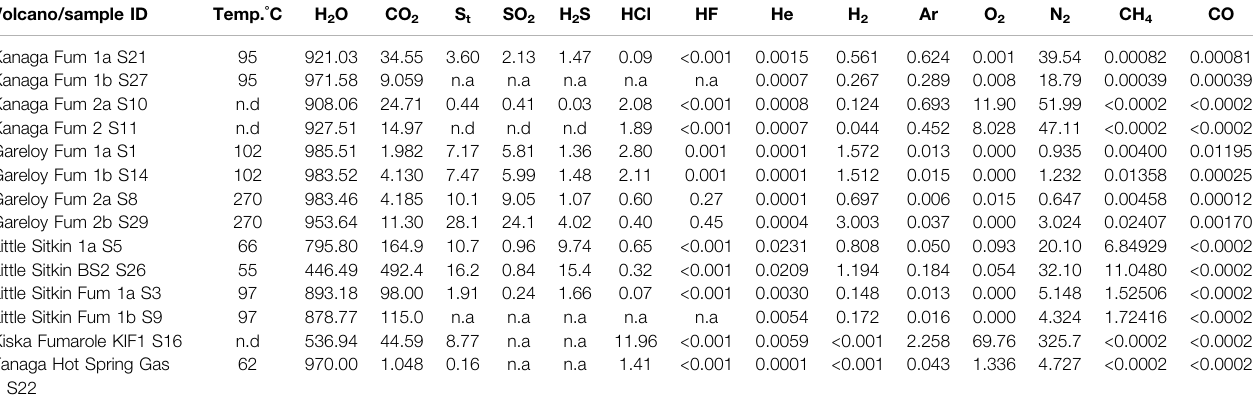
TABLE 1 | Gas chemical composition in mmol/mol total gas. All samples were collected in September 2015. Volcano/sample ID